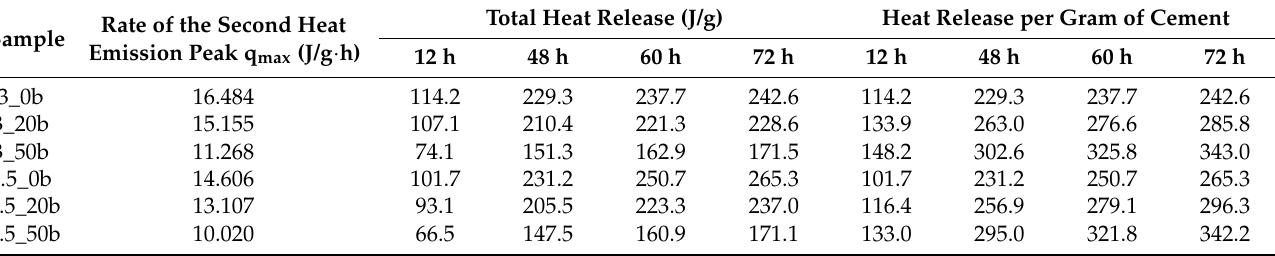
Table 4. Characteristic values of the hydration heat evolution curves of specimens at 25 ◦